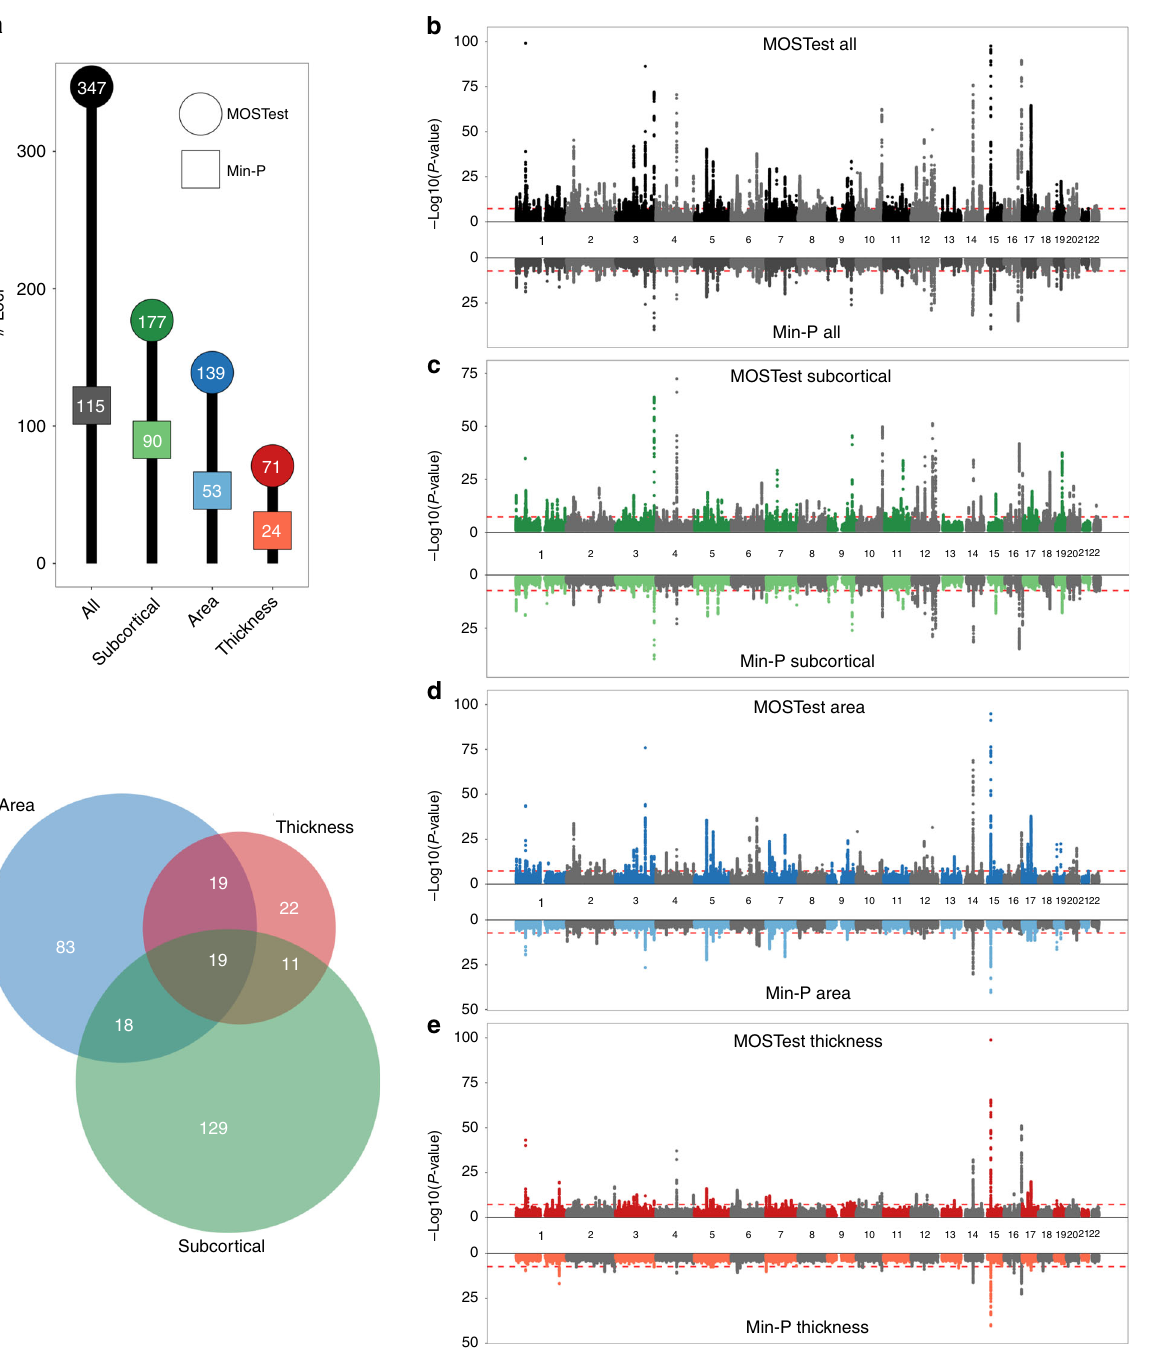
Fig. 1 MOSTest improves locus discovery. a Number of independent genome-wide signi fi cant loci identi fi ed (on the y axis and in the bubbles) for each set of features (on the x axis), by MOSTest (in darker colored circles) and by min-P (in lighter colored squares). b – e Miami plots, contrasting the observed − log p -values), shown on the y axis, of each SNP for MOSTest (top half) with min-P (bottom half), for each of the feature sets. The x axis shows the 10 ( relative genomic location, grouped by chromosome, and the red dashed lines indicate the genome-wide signi fi cance threshold of 5 × 10 − 8 . Note, y axis is clipped at − log 10 ( p -value) = 100. f Venn diagram depicting the number of loci, identi fi ed with MOSTest, overlapping between the three feature